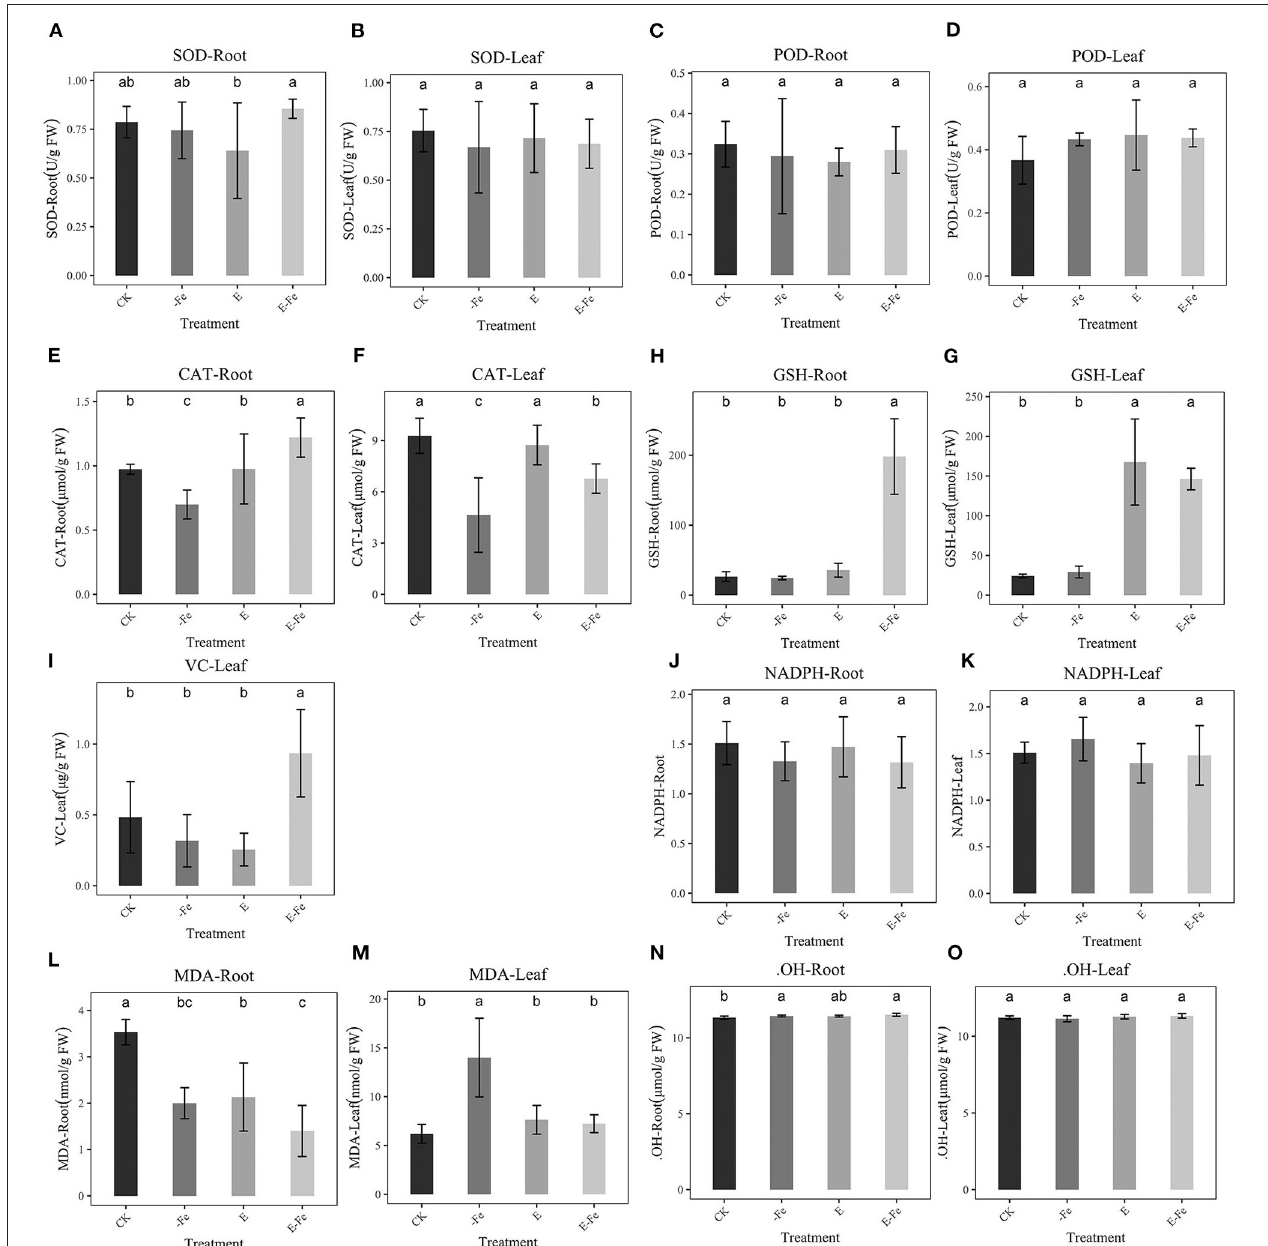
FIGURE 7 | Effect of P. liquidambaris on peanut under different Fe supply. (A) : Effect of P. liquidambaris on peanut SOD content in leaf under different Fe supply. (B) : Effect of P. liquidambaris on peanut SOD content in root under different Fe supply. (C) : Effect of P. liquidambaris on peanut POD content in leaf under different Fe supply. (D) : Effect of P. liquidambaris on peanut POD content in root under different Fe supply. (E) : Effect of P. liquidambaris on peanut CAT content in leaf under different Fe supply. (F) : Effect of P. liquidambaris on peanut CAT content in root under different Fe supply. (G) : Effect of P. liquidambaris on peanut GSH content in leaf under different Fe supply. (H) : Effect of P. liquidambaris on peanut GSH content in root under different Fe supply. (I) : Effect of P. liquidambaris on peanut VC in root under different Fe supply. (J) : Effect of P. liquidambaris on peanut NADPH in root under different Fe supply. (K) : Effect of P. liquidambaris on peanut NADPH in leaf under different Fe supply. (L) : Effect of P. liquidambaris on peanut MDA in leaf under different Fe supply. (M) : Effect of P. liquidambaris on peanut MDA in leaf under different Fe supply. (N) : Effect of P. liquidambaris on peanut .OH in root under different Fe supply. (O) : Effect of P. liquidambaris on peanut OH in leaf under different Fe supply. Data and errors are mean ± SD, n = 6, and different letters indicate significant differences among treatments. p < 0.05. E = P. liquidambaris inoculation. -Fe = 2 µ mol FeEDTA in Hogland nutrition. CK = 100 µ mol FeEDTA in Hogland nutrition.